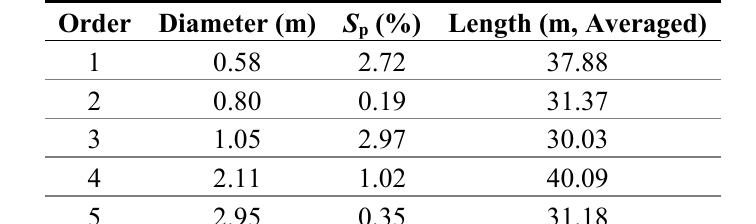
Figure 7. ( a ) Actual drainage network; ( b ) alternative drainage network of Seocho4 built with SWMM. Table 3. Conduit information depending on Strahler